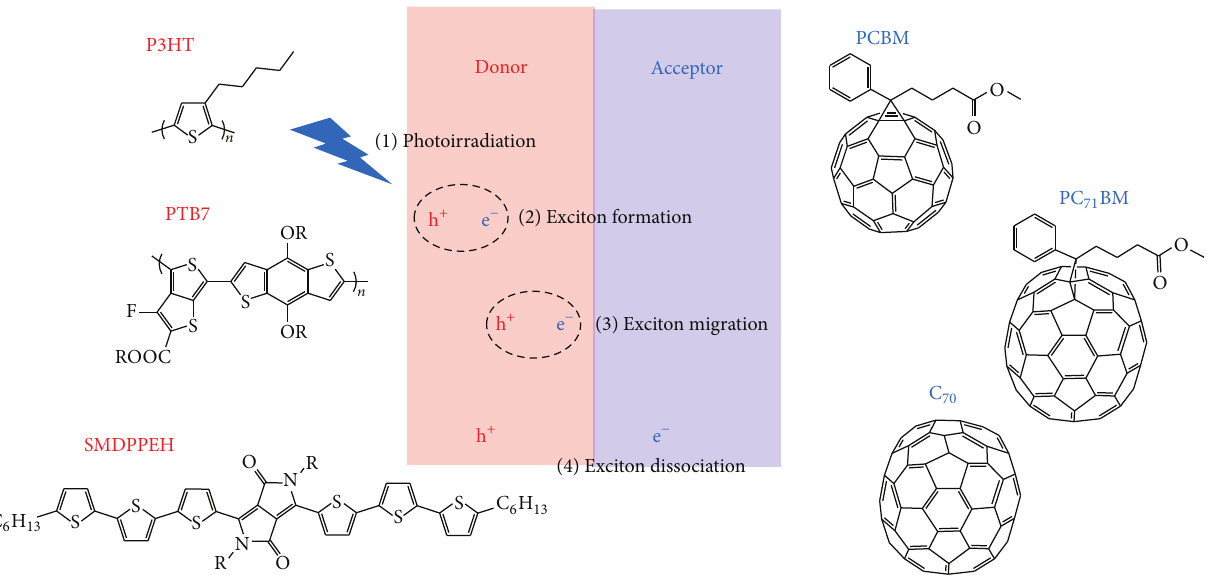
Figure 1: Exciton-carrier conversion process at D/A interface. Molecular structures of prototypical donors and acceptors are